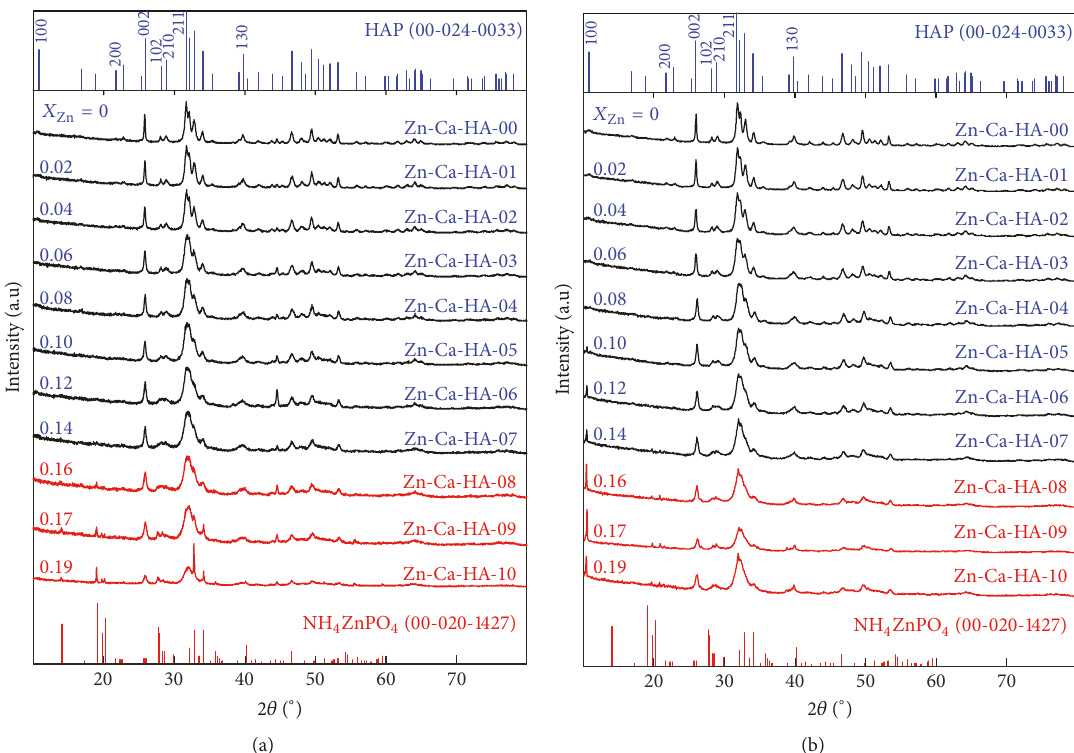
Figure 1: X-ray diffractograms (XRD) of the Zn-substituted hydroxylapatites [(Zn dissolution at 25 ∘ C with an initial pH of 2.00 for 360 d (b).